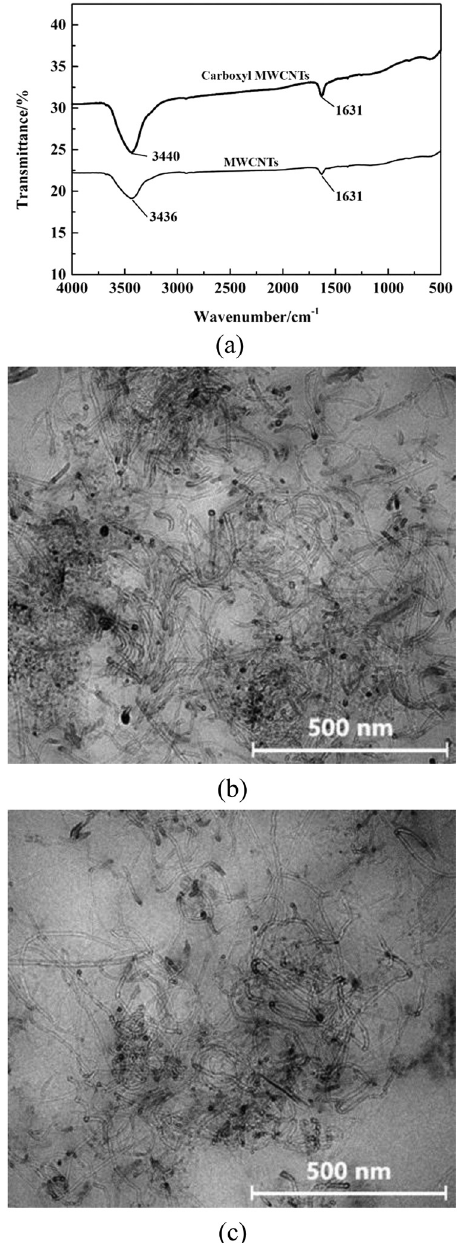
Figure 5: FTIP spectroscopy and TEM images of MWCNTs: ( a ) FTIP spectra of MWCNTs, ( b ) TEM image of unmodi fi ed MWCNTs in the epoxy matrix [ 35 ] , and ( c ) TEM image of modi fi ed MWCNTs in the epoxy